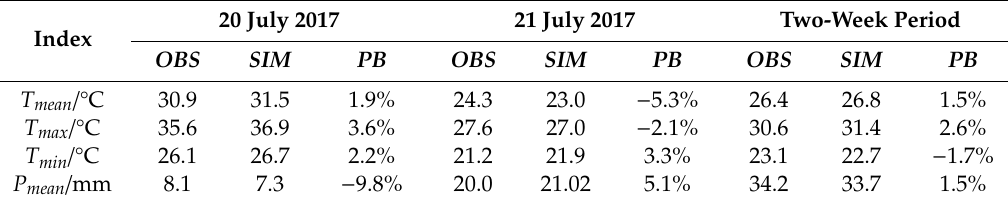
The percent bias ( PB , % ) between the observed meteorological station ( OBS ) and model-simulated ( SIM ) data for the average temperature ( T mean ), maximum temperature ( T max ), minimum temperature ( T min ), and average precipitation ( P mean